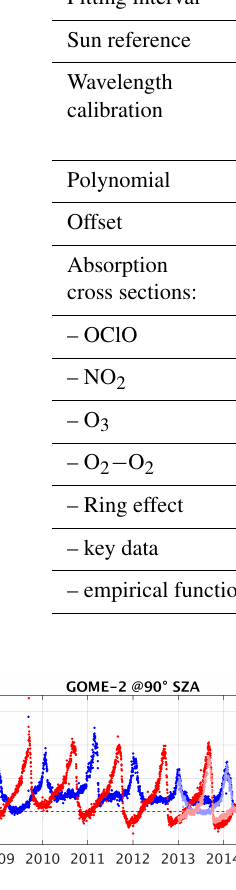
Figure 2. Daily GOME-2 OClO SCD time series for SZAs of 90 ± 1 ◦